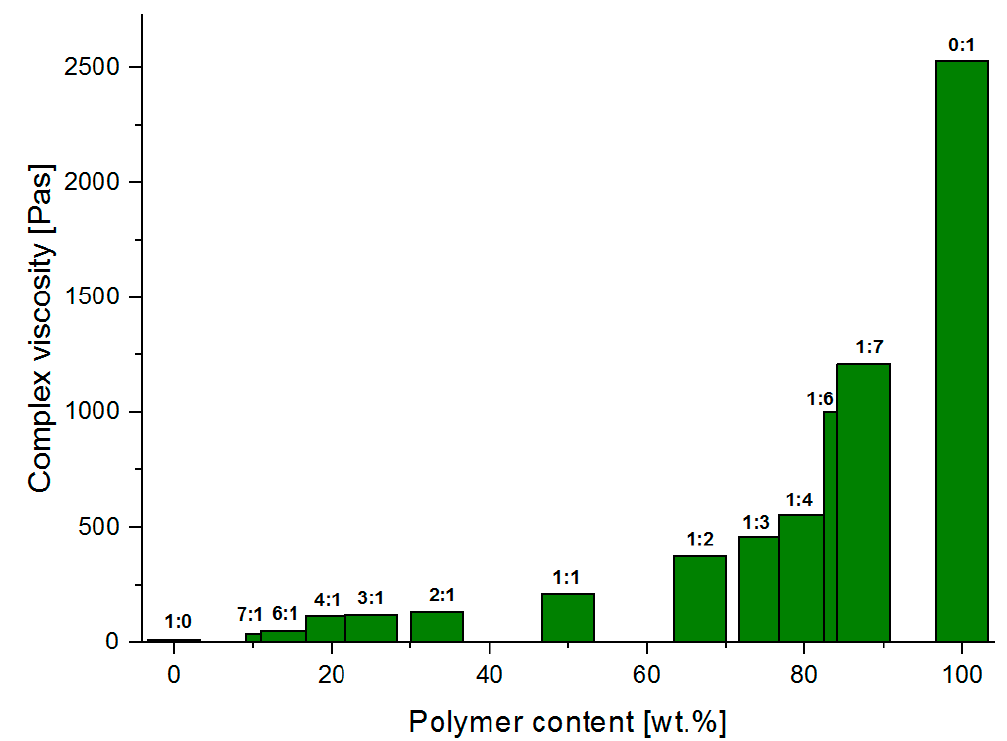
Figure 12. The dependence of the complex viscosity versus polymer content of the tested polymer-silicate hydrogel samples.